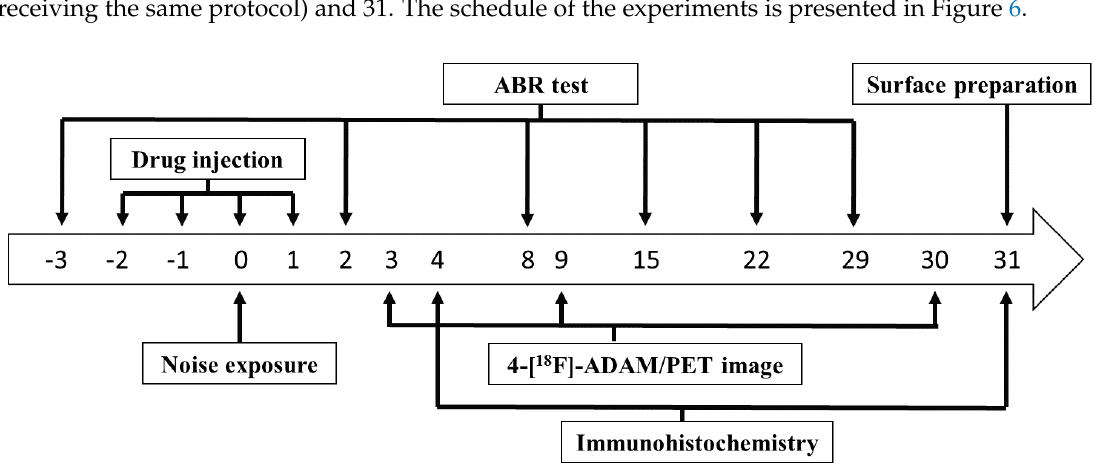
Figure 6. The diagram depicts the experimental schedule. Rats were exposed to noise on day 0. ABR tests were performed on days − 3, 2, 8, 15, 22, and 29. 4-[ 18 F]-ADAM/PET images were performed